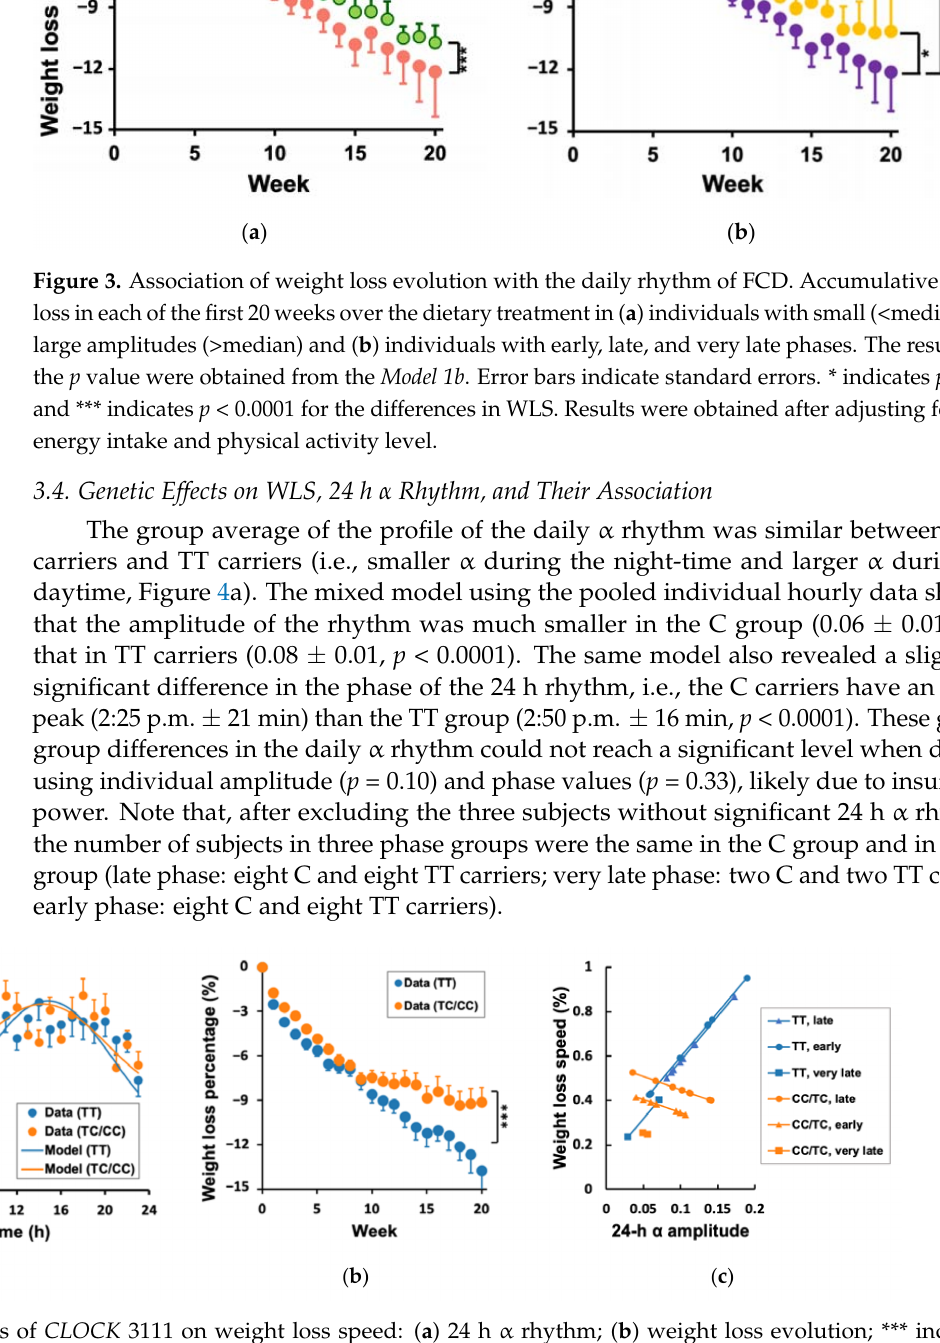
Figure 4. Genetic effects of CLOCK 3111 on weight loss speed: ( a ) 24 h α rhythm; ( b ) weight loss evolution; *** indi- cates p < 0.0001 for the difference in WLS between C and TT carriers obtained from Model 2b in which the effects of the 24 h α rhythm were controlled; ( c ) The interaction effect of the 24 h α rhythm (amplitude and phase) and CLOCK 3111T/C on WLS. The results were obtained from Model 3 in which the effects of the phase and amplitude as well as their interaction with the genotype were considered. Weight loss was presented as the percentage of initial body weight. Error bars indicate standard